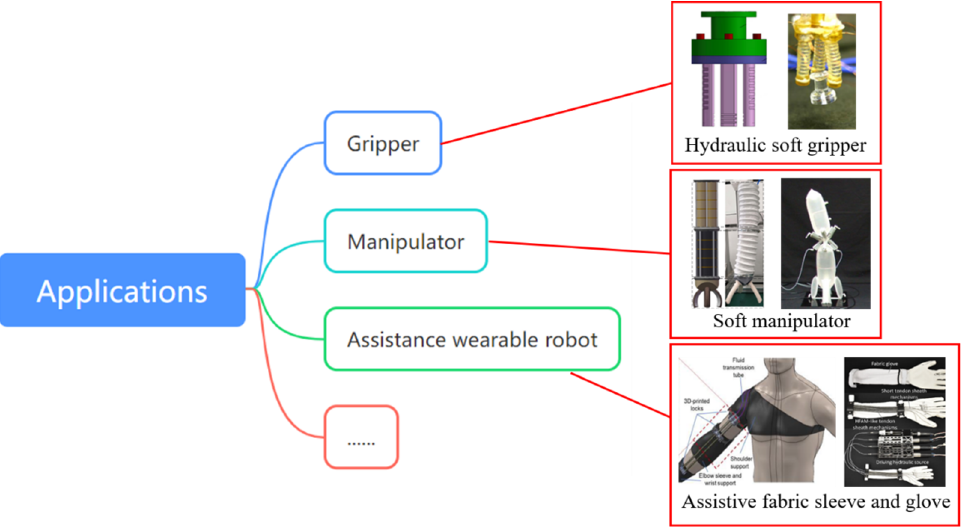
Figure 3. Recommended applications of hydraulic powered soft actuators [22,29,43,59–61].